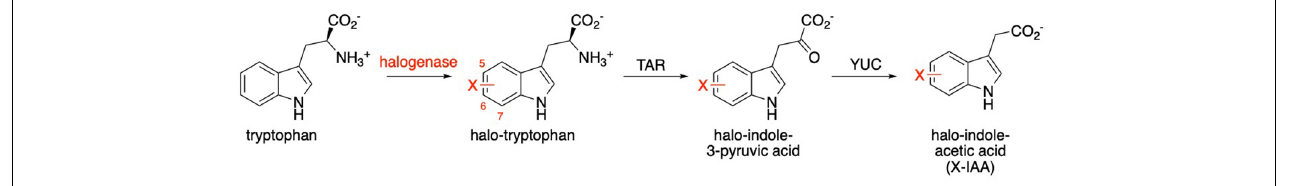
FIGURE 2 | Production of indole-3-acetic acid (IAA) from tryptophan. The role of the bacterial halogenase (incorporating halogen X, typically Cl) is indicated in red.